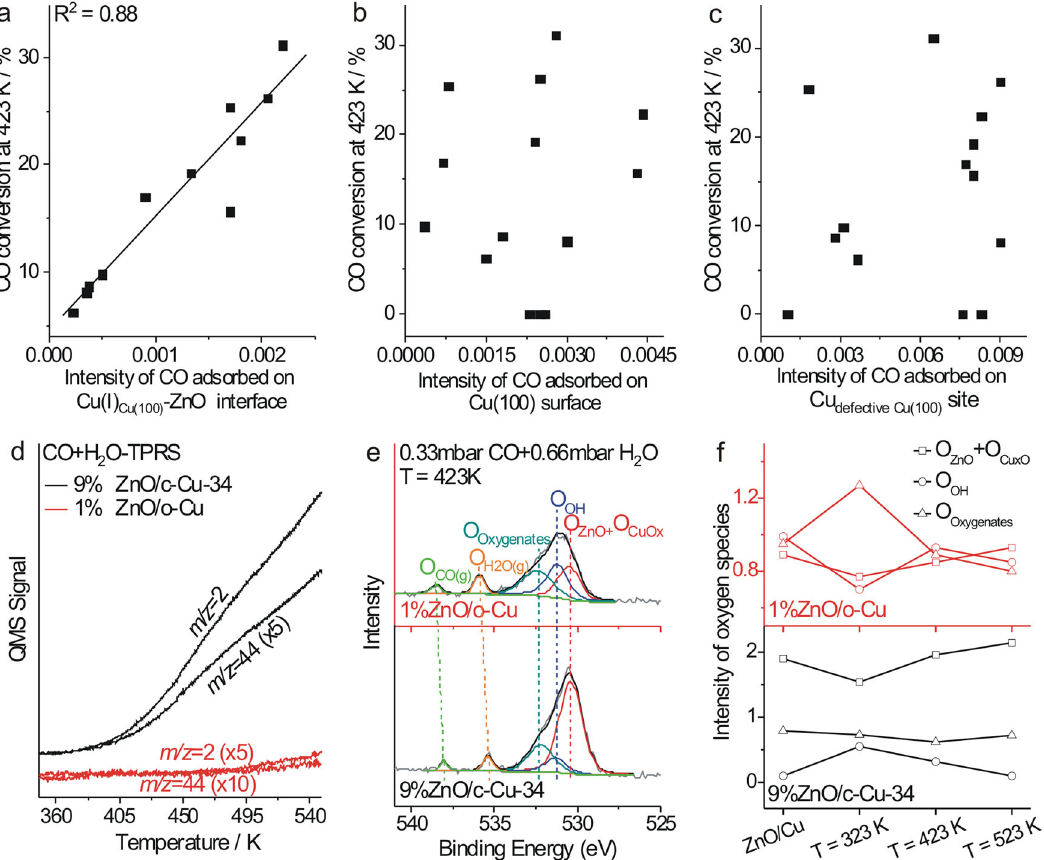
Fig. 4 Reaction mechanism of WGS reaction. CO conversion at 423 K as a function of the intensity of CO adsorbed on a Cu(I) Cu(100) -ZnO interface, b Cu (100) surface, and c Cu defective Cu(100) site derived from corresponding DRIFTS results; d Temperature-programmed reaction spectra of WGS reaction over 9%ZnO/c-Cu-34 and 1%ZnO/o-Cu catalysts; e O 1 s NAP-XPS spectra with peak- fi tting results of 9%ZnO/c-Cu-34 and 1%ZnO/o-Cu catalysts under 0.33 mbar CO + 0.66 mbar H 2 O at 423 K; f Variations of the intensity of oxygen-containing species on 9%ZnO/c-Cu-34 and 1%ZnO/o-Cu catalysts under 0.33 mbar CO + 0.66 mbar H 2 O at different temperatures derived from corresponding NAP-XPS